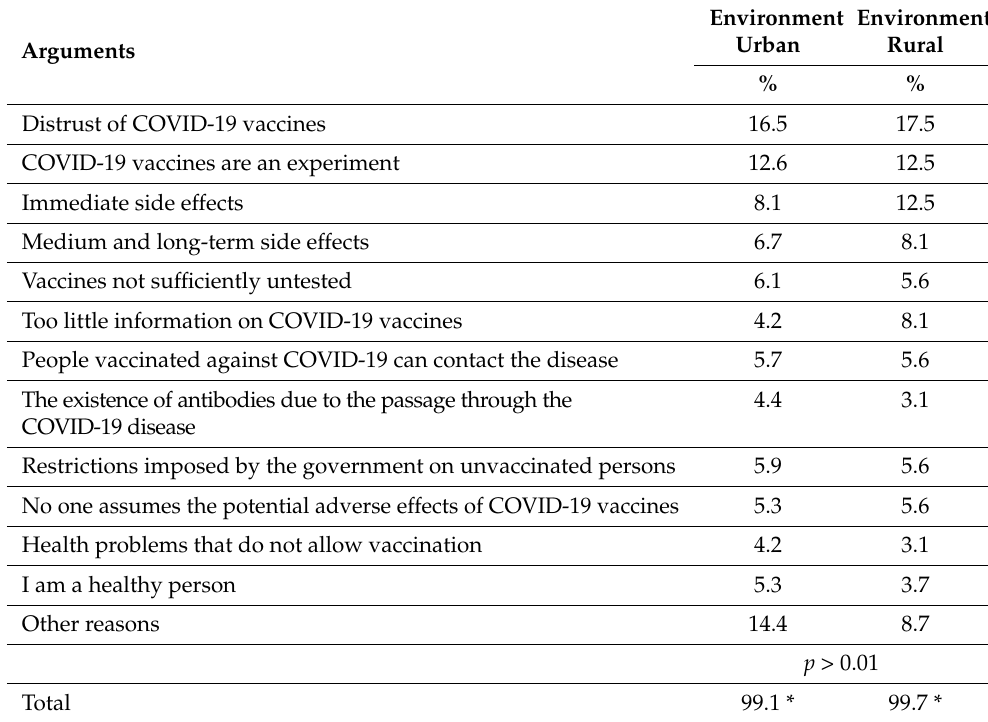
Table 4. Data presenting the main reasons invoked by people from rural and urban areas when arguing the non-vaccination